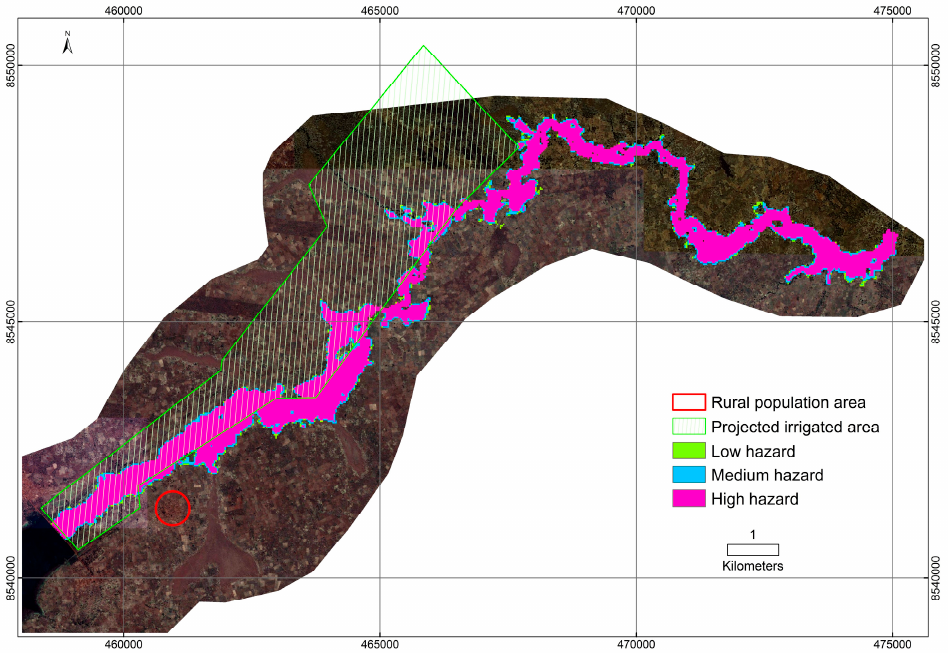
Figure 11. Hazard map derived from the inundation depth and velocity distributions. Predictions using the DEM SRTM TR and n = 0.04 m − 1/3 ·s.